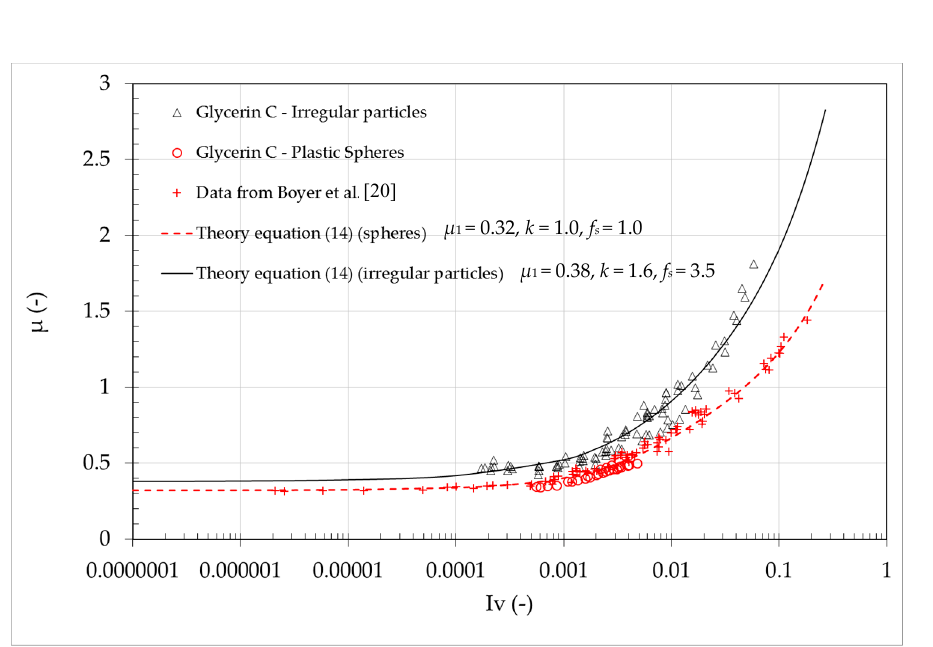
Figure 14. Plastic irregular particle–glycerin C solution: correlation between the friction coefficient µ and the viscous number I v plotted in a semi logarithmic chart to appreciate the value of the static friction coefficient µ 1 and a comparison with spheres-glycerin C solution and the data reported by Boyer et al. [20]